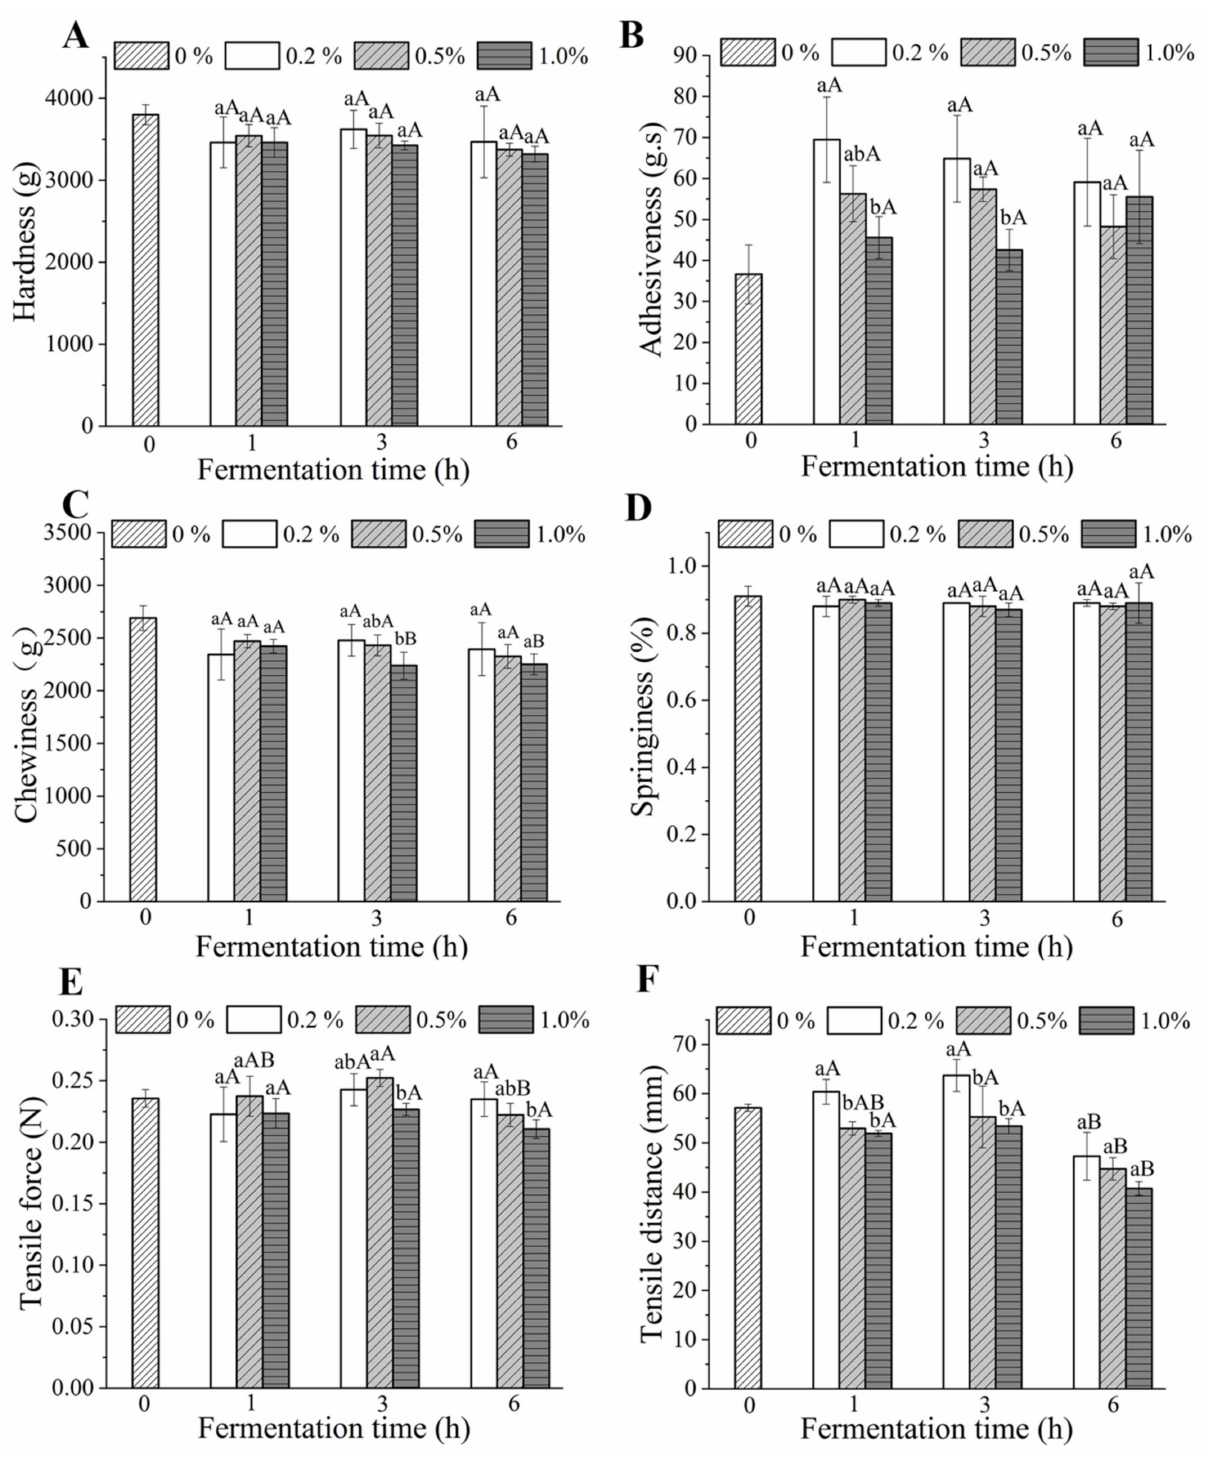
Figure 4. Effect of fermentation time and amount of yeast added on the textural properties of dried noodles. ( A ) Hardness; ( B ) Adhesiveness; ( C ) Chewiness; ( D ) Springiness; ( E ) Tensile force; ( F ) Tensile distance. Different lowercase letters indicate that the data related to different yeast additions are significantly different under the same fermentation time. Different capital letters indicate that the data related to different fermentation times are significantly different under the same yeast